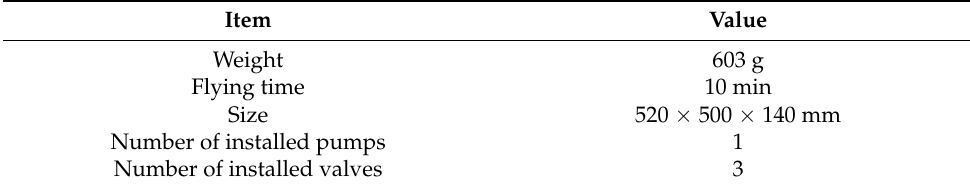
Table 2. The specifications of the drone.